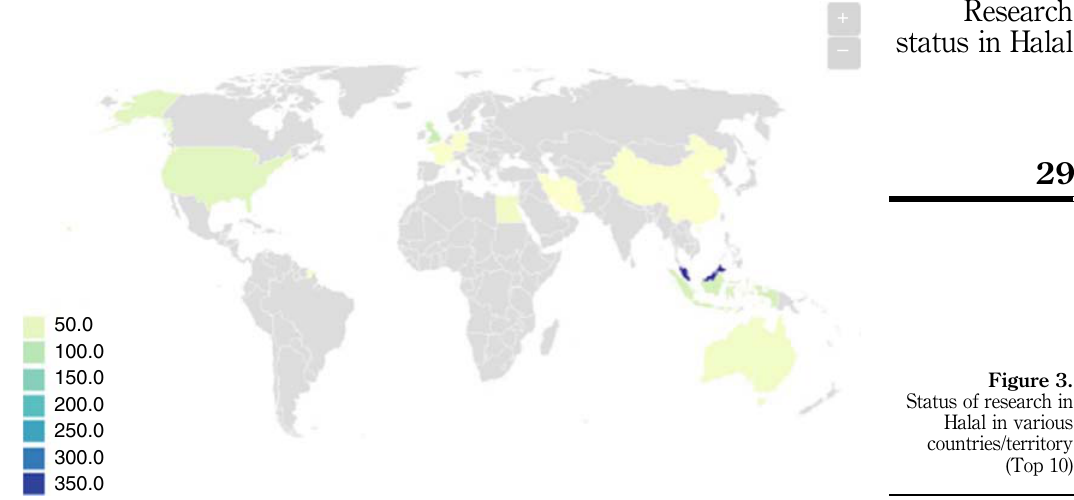
Figure 3. Status of research